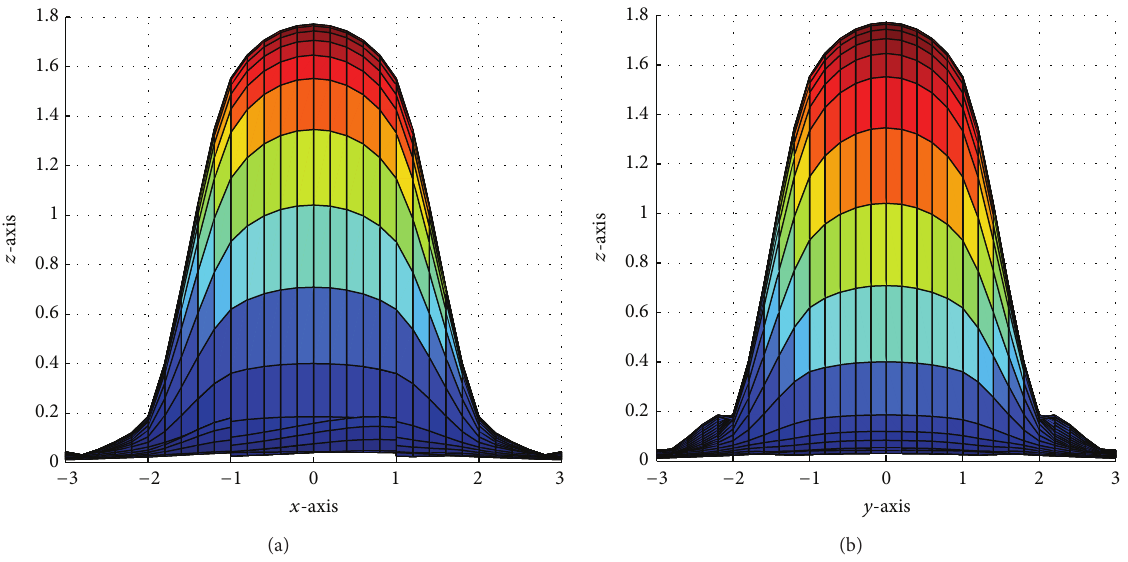
Figure 17: Positivity preserving surface: (a) 𝑥𝑧 -view and (b) 𝑦𝑧 -view for Figure 16, respectively.